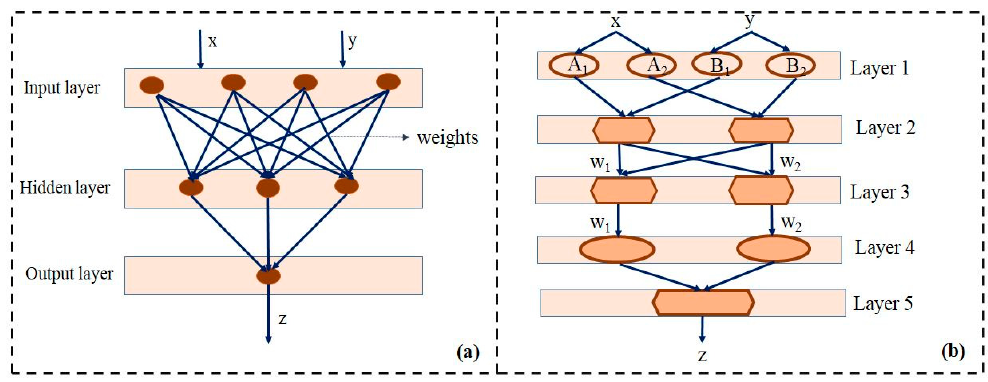
Figure 1. Schematics of artificial neural network (ANN) ( a ) and adaptive network based fuzzy inference system (ANFIS) ( b ) architecture. “x” and “y” represent the input variable whereas the “z” characterizes the output variable in both the ANN and ANFIS architecture. The oval structures in layer 1 and layer 4 represent the adaptive nodes. The pentagonal structures in layer 2, 3, and 5 are the predefined fixed nodes.